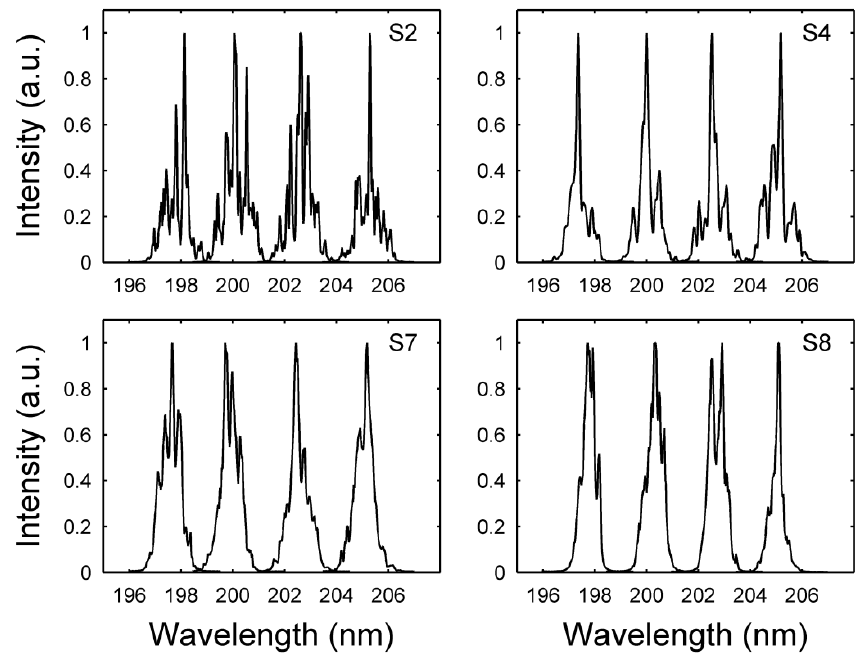
Figure 5. The spectra of deep ultraviolet (DUV) generated in several samples (S2, S4, S7, S8) obtained in separate growth